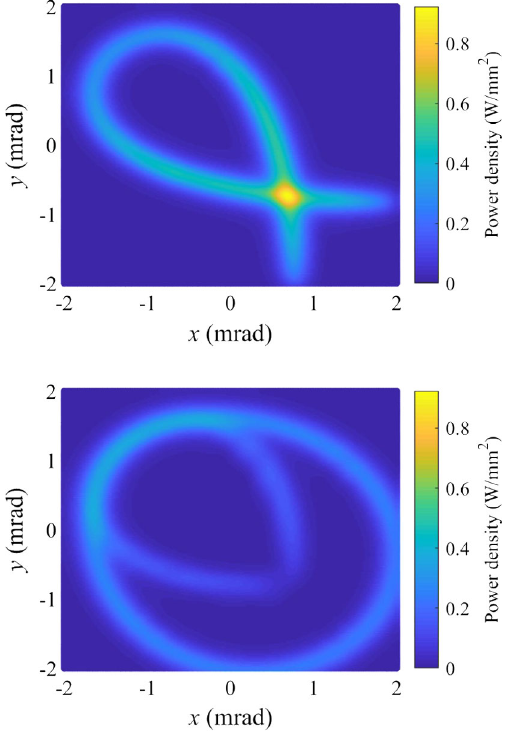
FIG. 11. The transverse distribution of power density for the linear mode (upper) and circular mode (lower) in the Knot